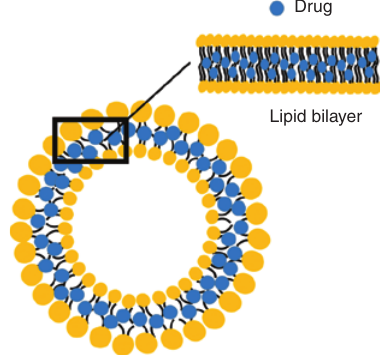
Figure 5: Schematic illustration of liposome.